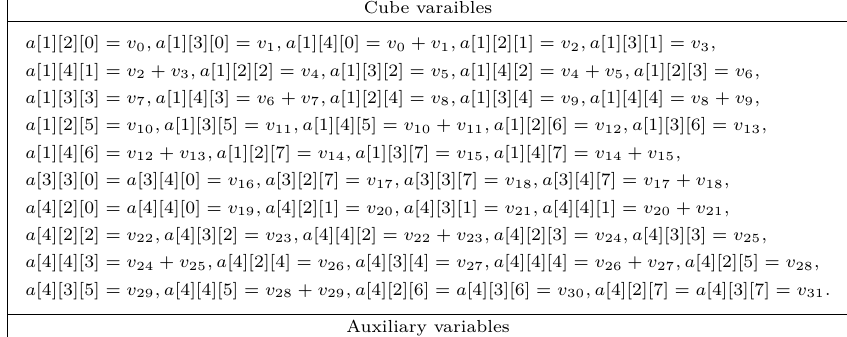
Table 12: A 32-dimensional cube for Ketje Jr V1 with 72-bit keys, where ( n a , n i ) = (29 , 34). In total, there are 57 bits key information involved in both auxiliary variables and involved key